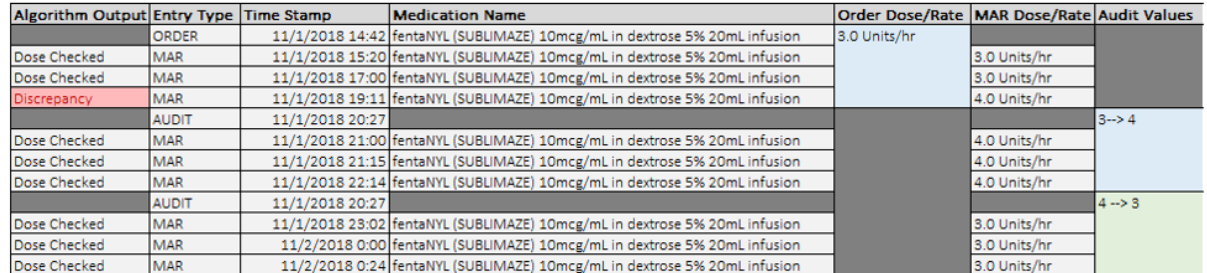
Figure 7. Example of the delayed entry of a verbal order causing a discrepancy to be detected. A verbal order was given at the bedside and the medication was appropriately adjusted, but the order was not documented until after the MAR documentation was placed. The algorithms allow a 30-minute window for verbal orders to be entered before calling a discrepancy, but in this example the order audit for the verbal order rate was not entered until 76 minutes later. MAR: medication administration